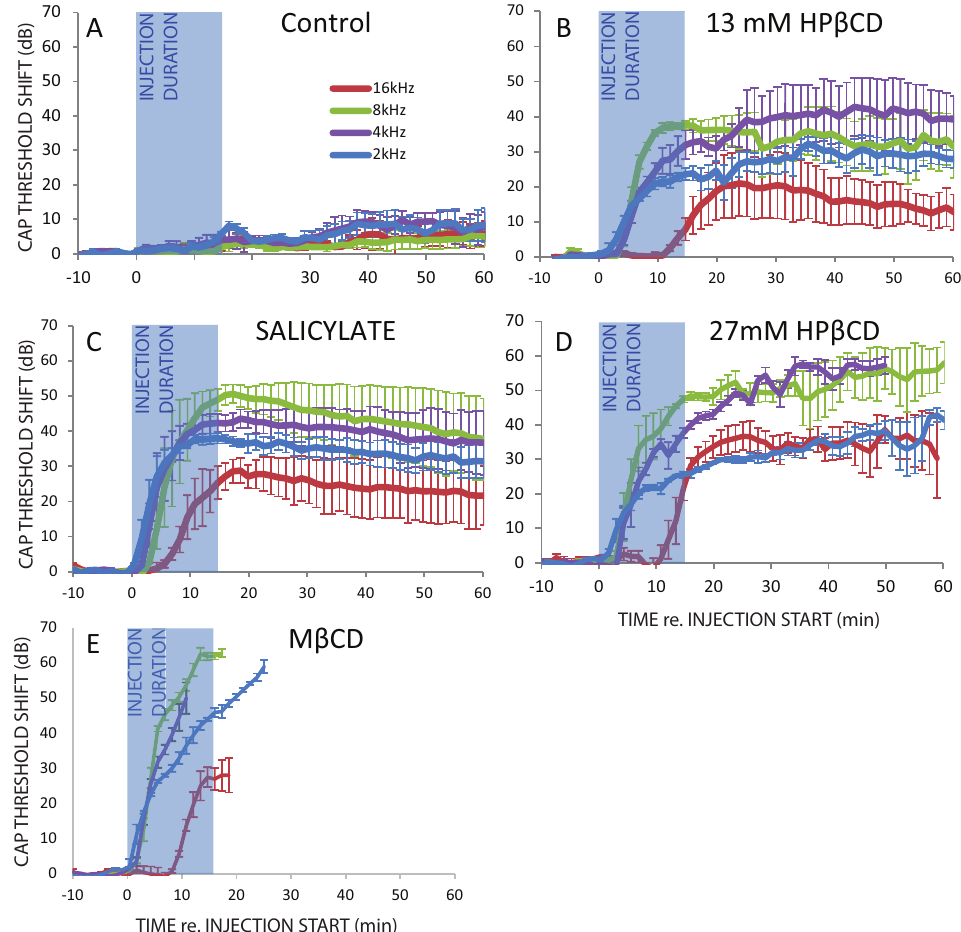
Fig 1. Cochlear action potential (CAP) threshold shifts as a function of time before, during, and after apical injection of various ototoxic solutions. Semi-transparent blue rectanglesspanning0 to 15 minutes identify when apicalinjectionsoccurred. There were a total of three ears from three guineapigs in each of the five groups.